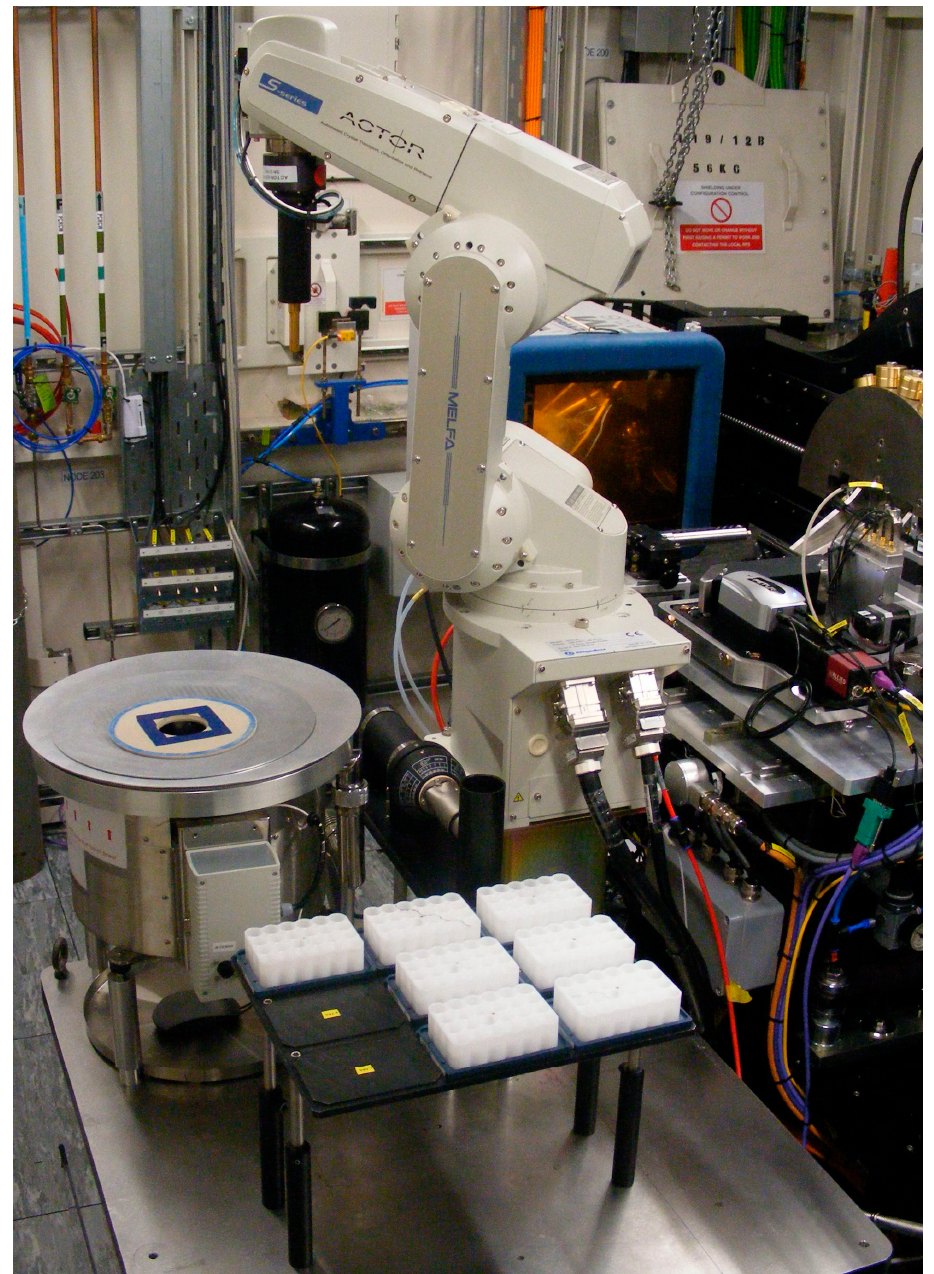
Figure 8. The robotic sample changer. The Dewar for storing unipucks is shown to the left of the robotic arm while the trays for holding sample mounts under ambient conditions are shown in the foreground. The aperture in the sliding lid of the Dewar is indicated by a blue square inside a blue circle for the image-recognition system. The camera for locating the lid aperture is mounted above the robot table and not shown here.